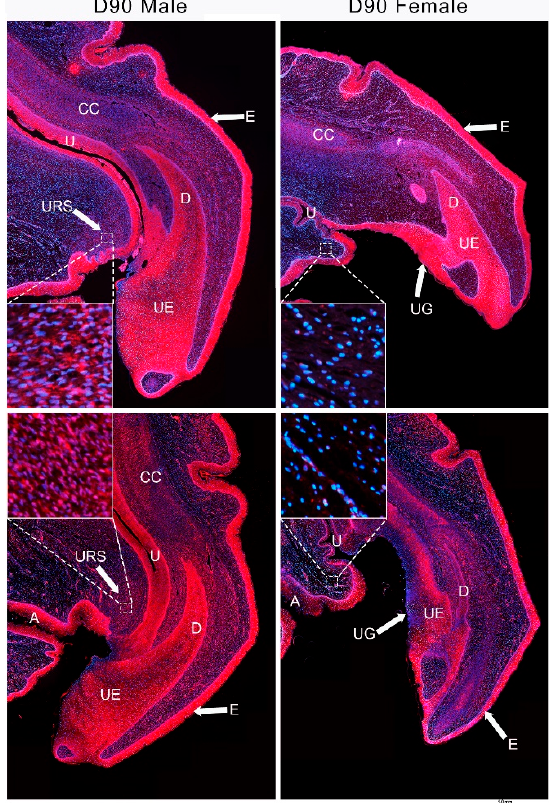
Figure 4. IGF1 and proliferating cell nuclear antigen (PCNA) distribution in phalluses at day 90 pp. In both male and female phalluses, IGF1 ( top ) and PCNA ( bottom ) are expressed in epithelial cells and in the corpora cavernosa. However, IGF1 and nuclear PCNA are found only in the URS of male phalluses (see insets). CC: corpus cavernosum, D: diverticulum, E: epithelium, U: urethra, UE: urethral epithelium, UG: urethra groove, URS: urorectal septum, red staining: IGF1 ( top ) and PCNA ( bottom ), and blue staining: DAPI (4 ′ ,6-diamidino-2-fenilindol). Scale bar, 1.0 mm. Figures from [15].